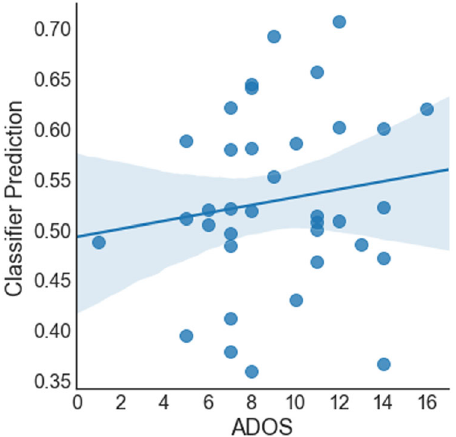
Fig. 4 Class probabilities based on machine-learning (ML) classi fi ca- tion and expert ratings.